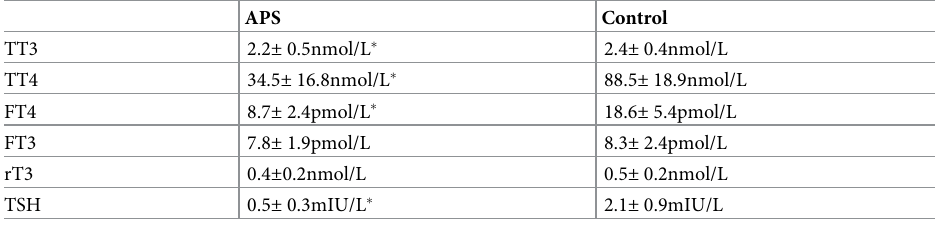
Table 3. Thyroid function test results of APS and